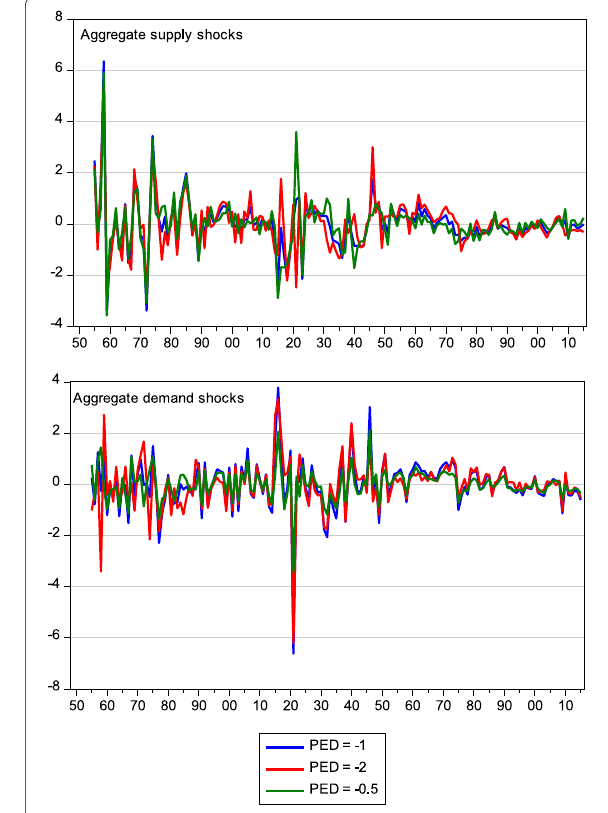
Fig. 11 Aggregate supply and demand shocks under varying assumptions of price elasticity of demand